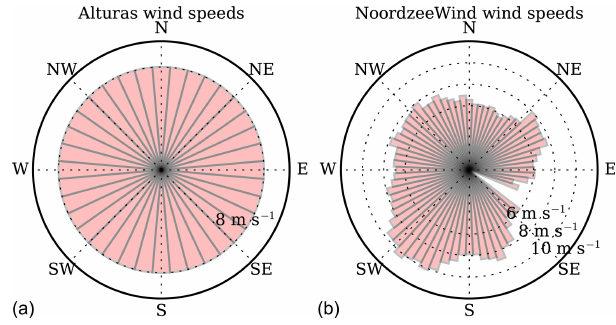
Figure 6. Panel (a) : the assumed directionally averaged wind speeds for Alturas, California, separated into 36 bins, every 10 ◦ . Each direction is assumed to have an average wind speed of 8ms − 1 . Panel (b) : the directionally averaged wind speeds of the NoordzeeWind meteorological mast, separated into 72 bins, every 5 ◦